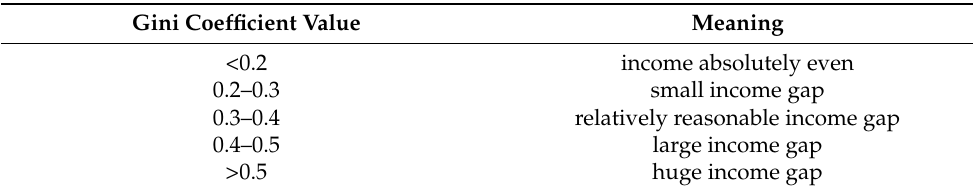
Table 1. The value range meaning of the Gini